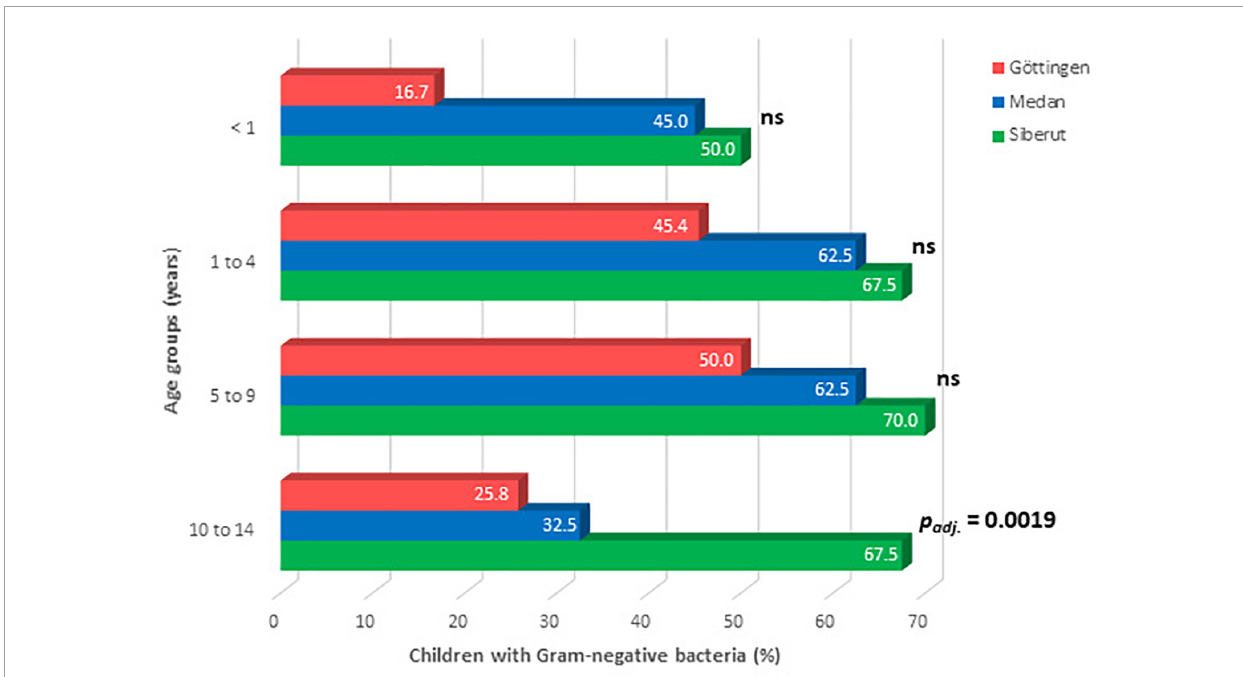
FIGURE3 Age-related contamination of children’s hands with Gram-negative bacteria in the three study regions. Data were analyzed by Chi-square test, with Bonferroni-adjustment of p -values (ns, not significant).